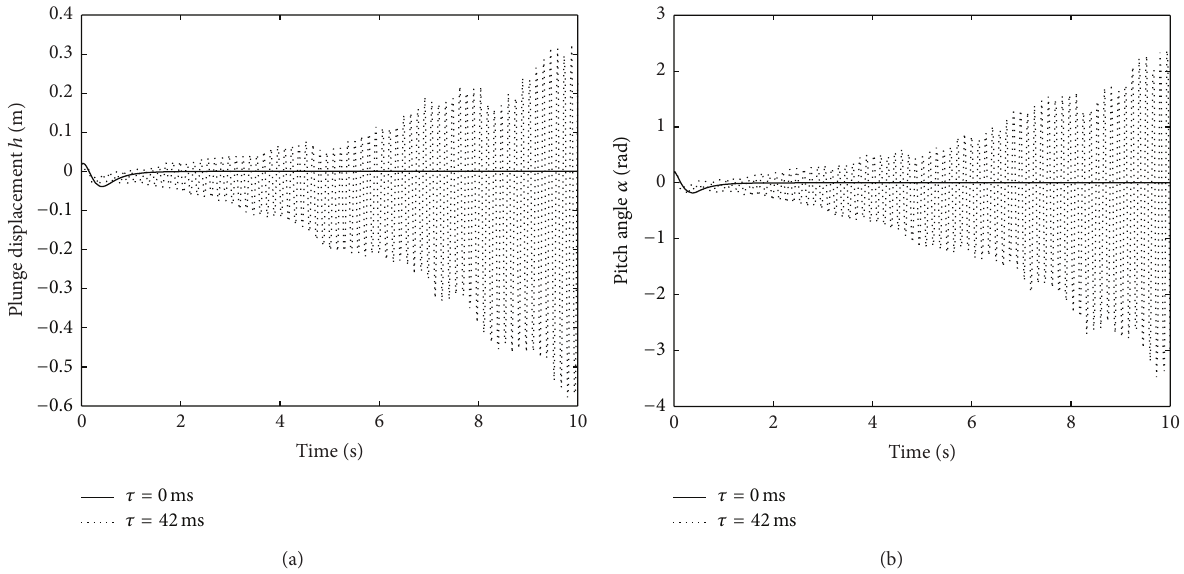
Figure 8: Time histories: (a) plunge and (b) pitch at 𝑈 = 20 m/s.